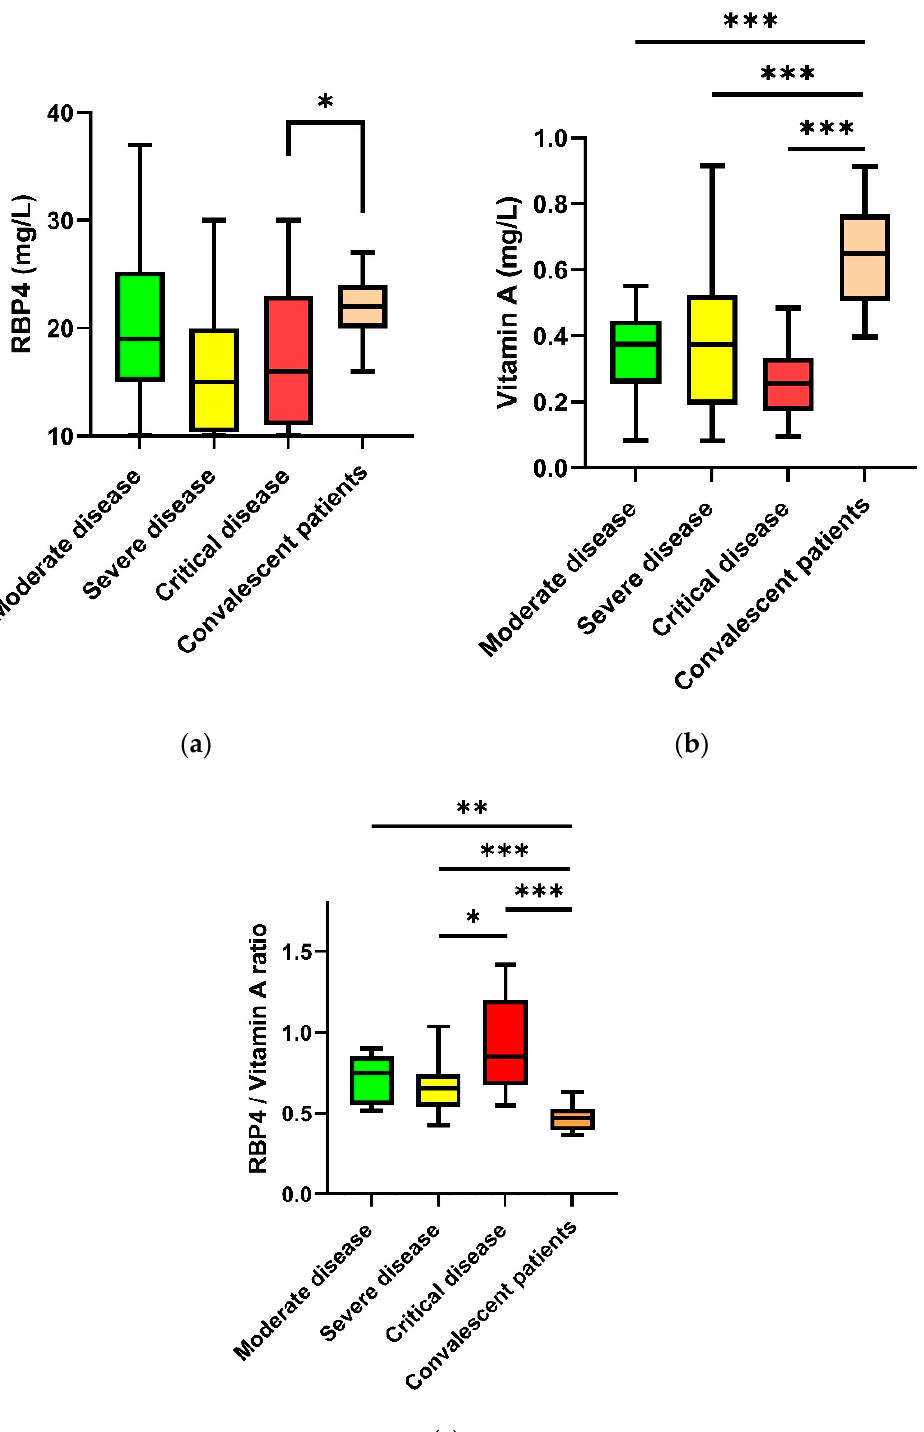
Figure 2. RBP4 ( a ), vitamin A ( b ) plasma levels and molar RBP4/vitamin A ratio ( c ) in hospitalized patients (moderate, severe, critical disease) and convalescent patients. Subgroups were tested for differences by the Bonferroni or Games–Howell post hoc test. The RBP4 plasma levels in critically ill patients were significantly lower compared to plasma levels in convalescent patients. The vitamin A plasma levels in all subgroups of acutely ill patients were significantly lower compared to plasma levels in convalescent patients. RBP4, retinol-binding protein 4; * p < 0.05, ** p < 0.001, *** p < 0.001.